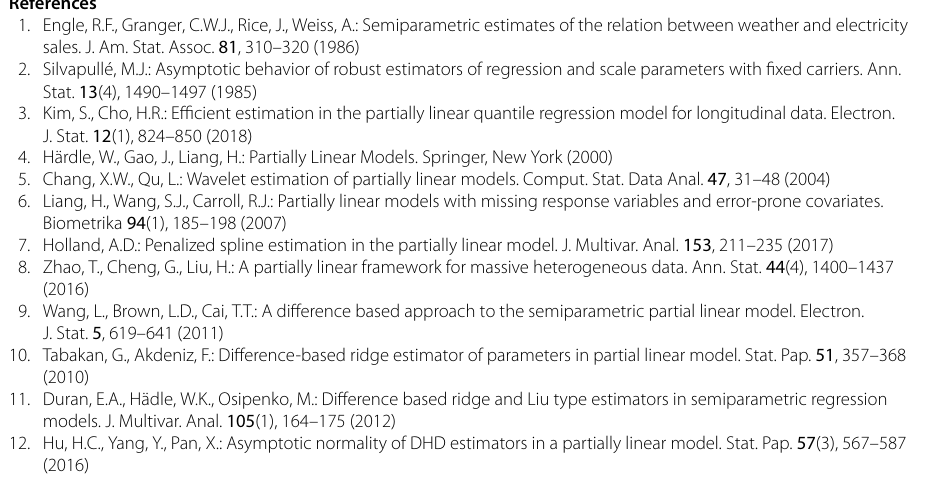
and N (0,1), and QQ-plot of M ˆ fn – f